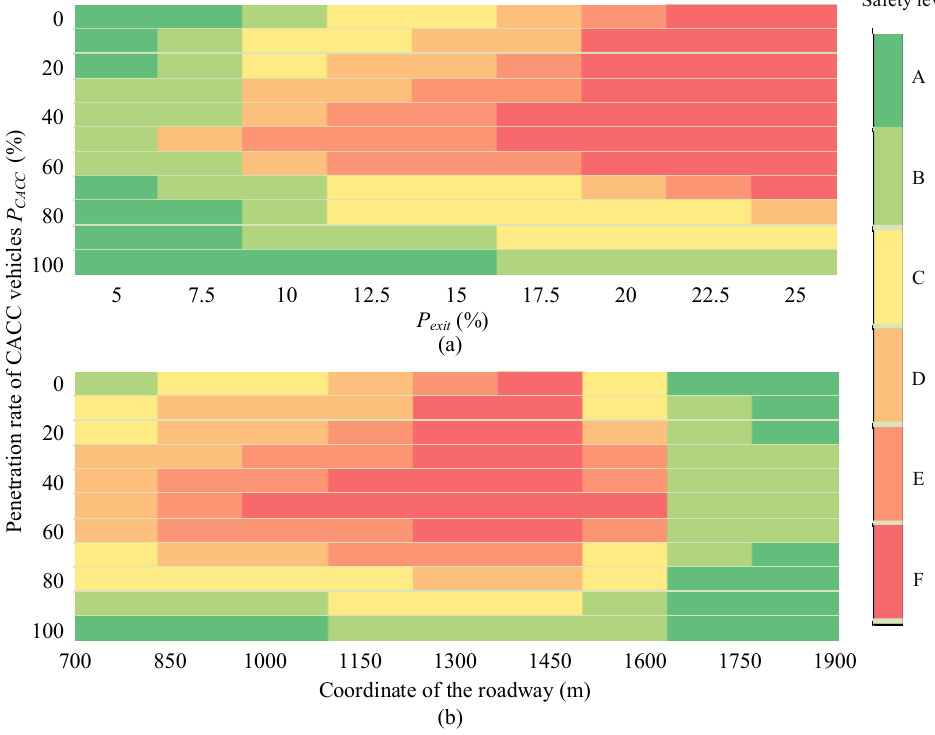
Figure 13. Distribution of safety levels. ( a ) denotes the distribution of safety levels over P CACC and P exit , and ( b ) denotes the distribution of safety levels along the roadway.